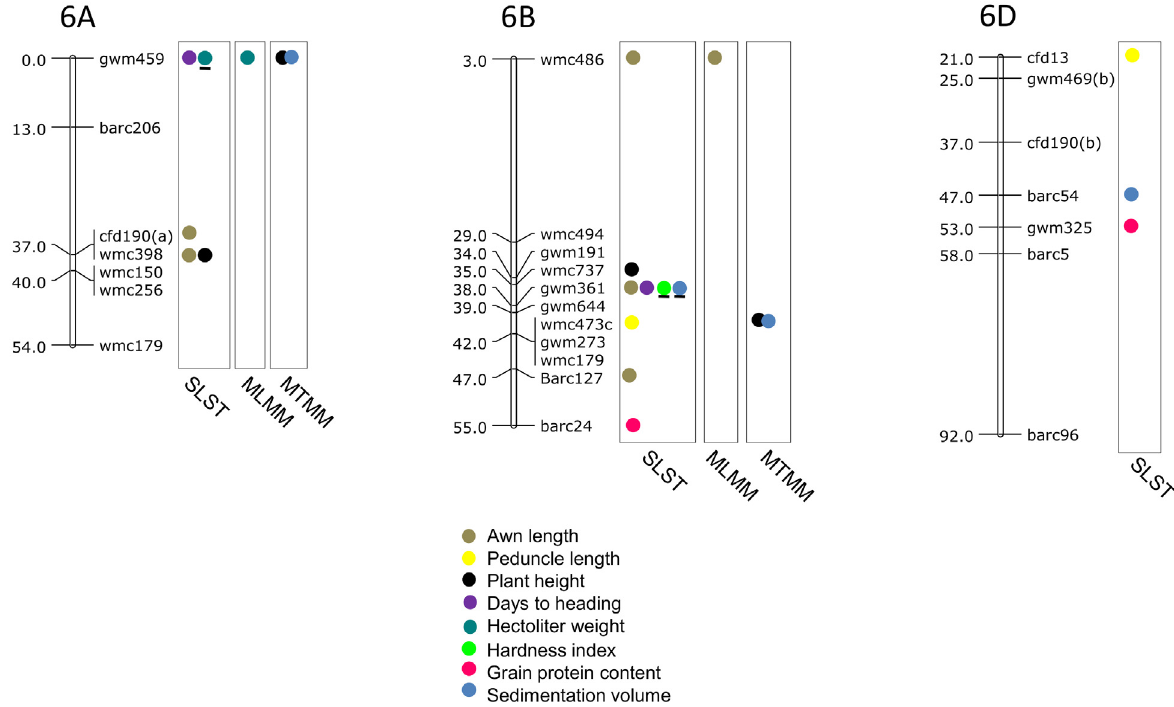
Fig 8. SSR genetic linkage maps of homoeologous group 6 chromsomes showing markers-trait associations (markers associated with different traits are shown by solid circles with different colours), black bar given below the solid circle represents that MTA qualified FDR criterion; markers are indicated to the right and map distances (cM) are indicated to the left of the vertical bar (based on the consensus linkage map of Somers et al. [76]).